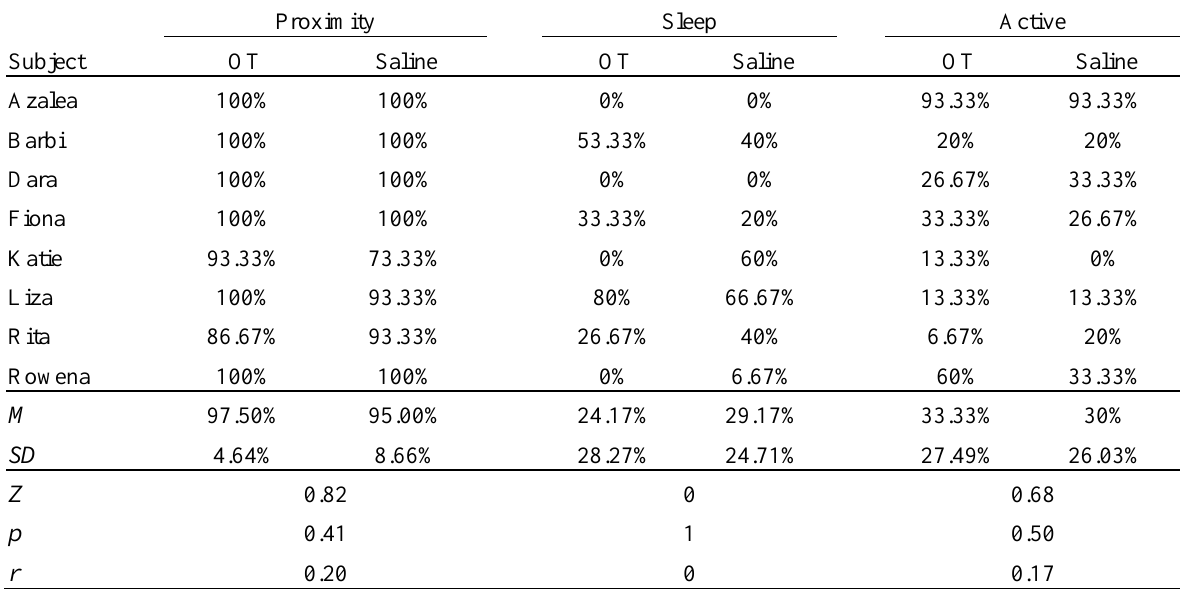
State Behaviors by Percentage of